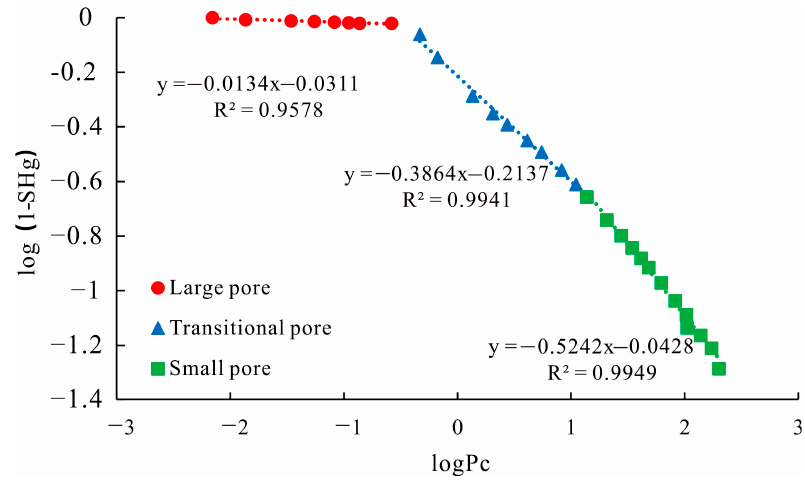
Figure 16. Plot of lg(1-SHg) versus lgPc using HPMI from Sample 3. Table 8. Fractal Dimensions of the samples from IPMI.